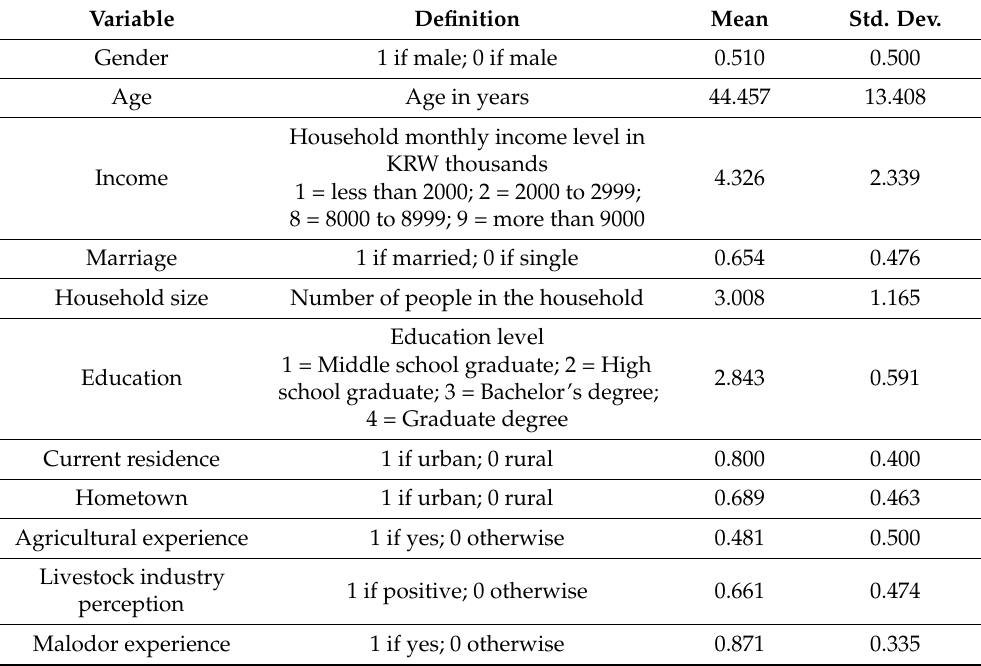
Table 1. Variable Definition and Summary Statistics ( N =